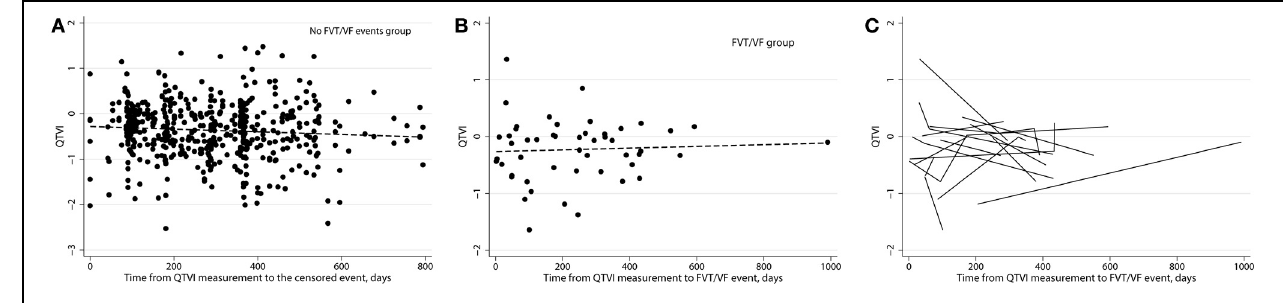
with ICD shock. (C) Line “spaghetti” plots of the longitudinal relationships between QTVI NF and actual time of FVT/VF for each patient with FVT/VF